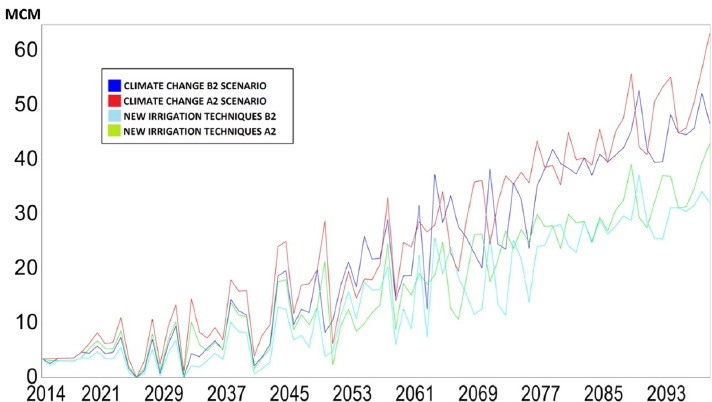
Figure 9. Change in unmet water demand under climate change scenarios associated with new irrigation techniques.